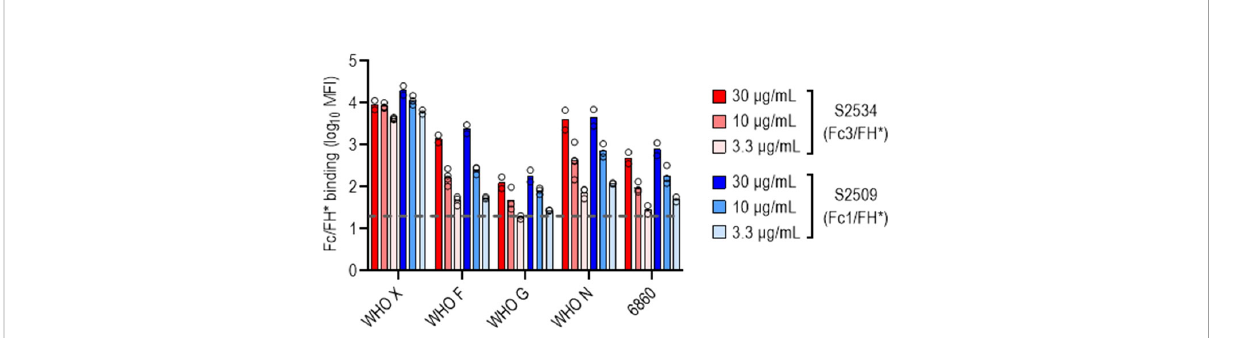
FIGURE 6 N. gonorrhoeae resistant to S2534 (Fc3/FH*) bind lower amounts of the fusion proteins. Binding of S2509 (Fc1/FH*) and S2534 (Fc3/FH*) to the four strains of N. gonorrhoeae that were resistant to killing by S2509 (>50% survival in Figure 5) was measured by fl ow cytometry. WHO X (H041) that was fully susceptible to S2509 and S2534 (100% killing) was included as a comparator. The Y-axis shows the log 10 median fl uorescence intensity (MFI) of fusion protein binding (mean and individual values of 2-4 separate experiments is shown). The dashed grey line indicates the average value of the conjugate controls (21; range from